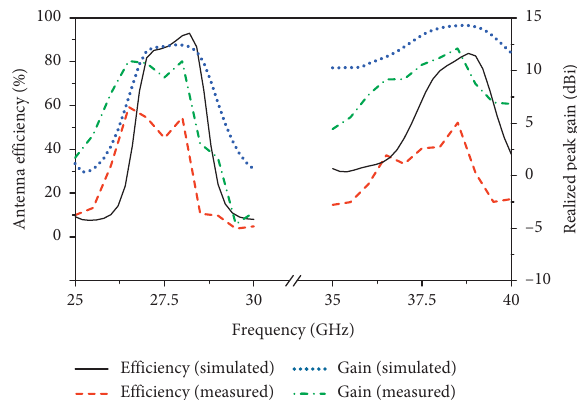
Figure 12: Antenna efciency and realized peak gain of the proposed antenna